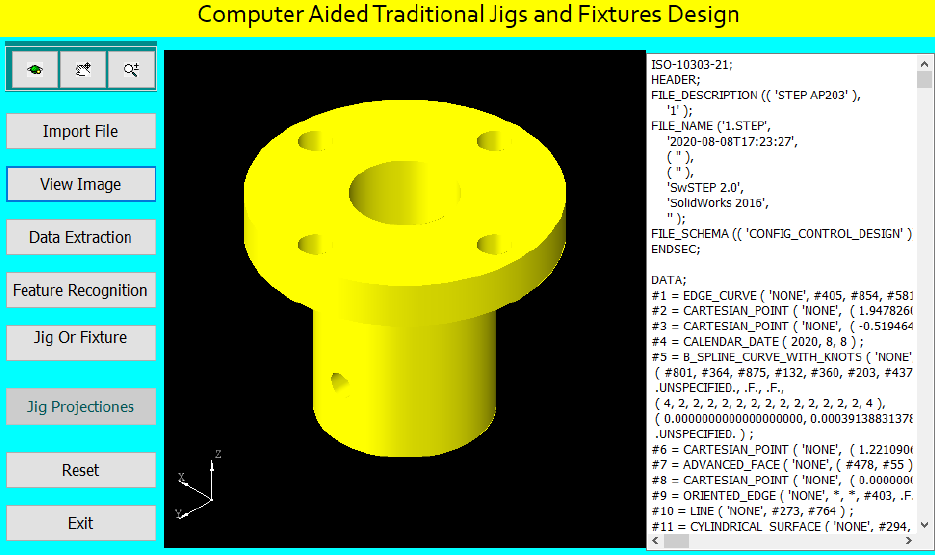
Figure 10. The system shows the part and the STEP AP-203 file.